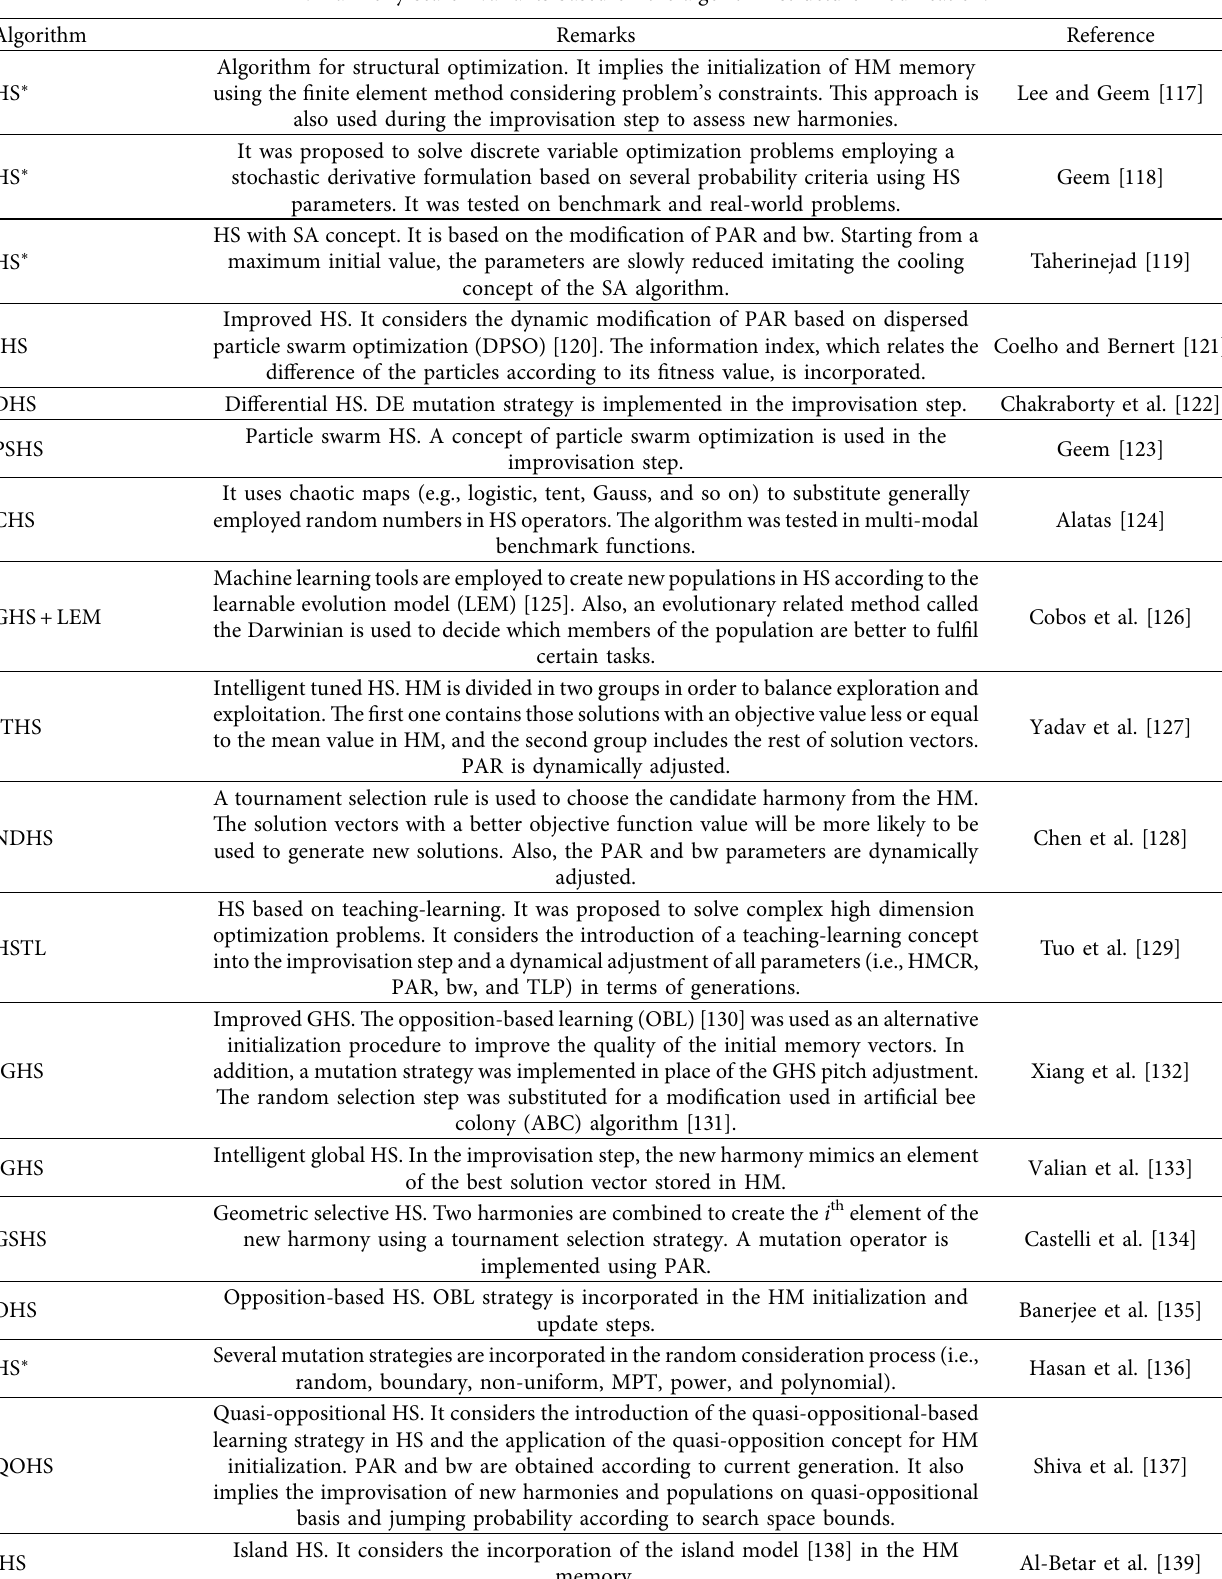
Table 4: Harmony search variants based on the algorithm structure modification.